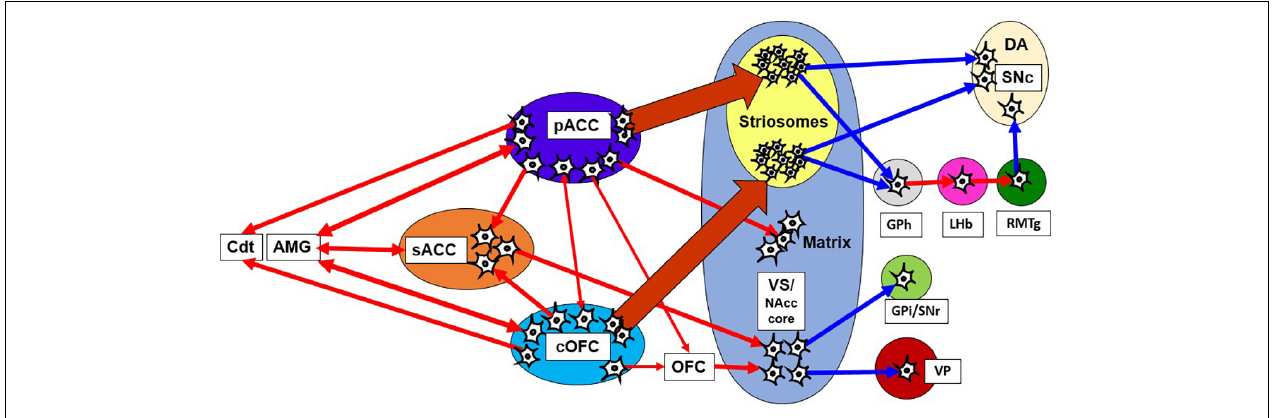
FIGURE 8 | Network of pessimistic decision-making in primates. The network consists of the pACC and cOFC that have interconnections and could reciprocally interact with the amygdala and sACC. The pACC and cOFC send output signals to the Cdt, thalamus and striosome compartment of the striatum, which in turn could modulate dopaminergic signals directly and indirectly. Red line indicates an excitatory connection, and a blue line indicates inhibitory connection. The pACC and cOFC send signals preferentially to striosomes in the anterior striatum. The VS-VP pathway is causally involved in anxious behaviors such as stereotypies. AMG, amygdala; GPi, internal globus